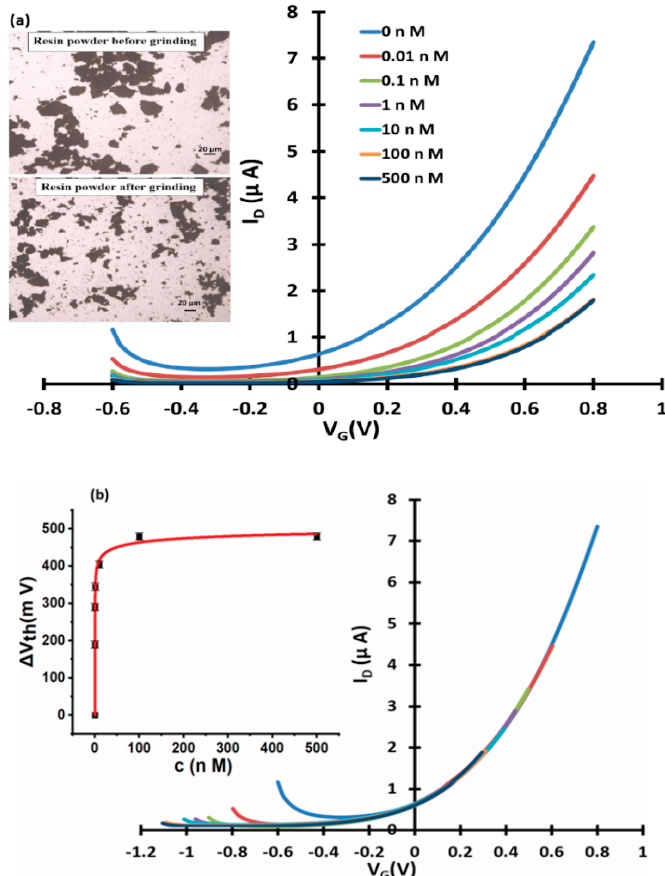
Figure 6. WGTFT fluoride response with finely ground La resin membrane. ( a ) Transfer characteristics of finer-ground La-loaded chelating resin-sensitised SnO 2 WGTFT gated under increasing F − concentrations from NaF in the outer pool. Inset to 6a: resin powder before/after grinding with pestle and mortar. ( b ) Master transfer characteristic. Inset to 6b: response characteristic with fit to Equation (3).